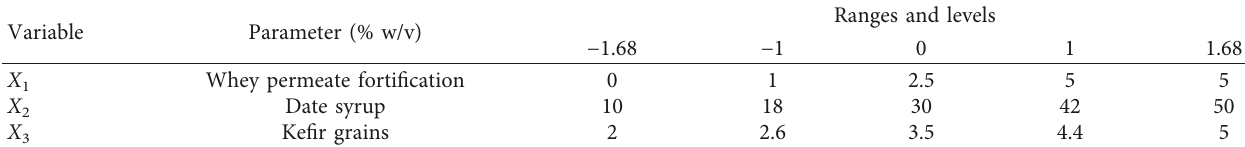
Table 1: Independent variables and coded levels for